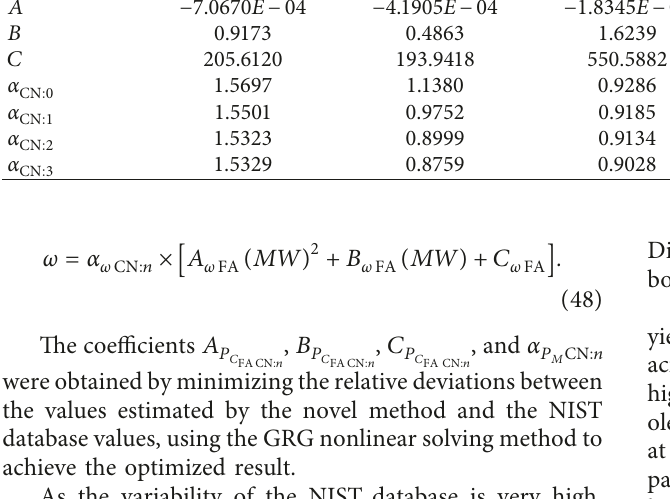
Table 25: Coefficients for the estimation the temperature nondependent properties according to equation (49).